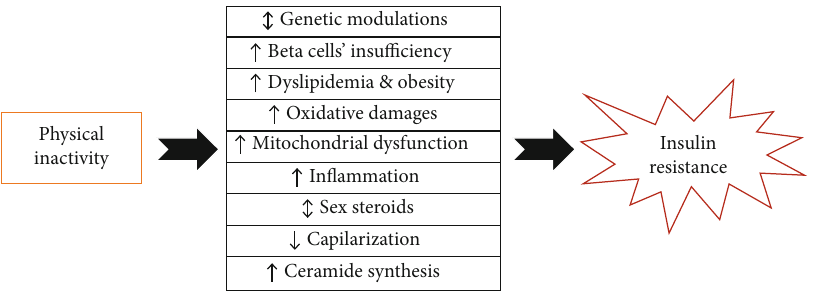
Figure 2: Possible links between physical inactivity and insulin